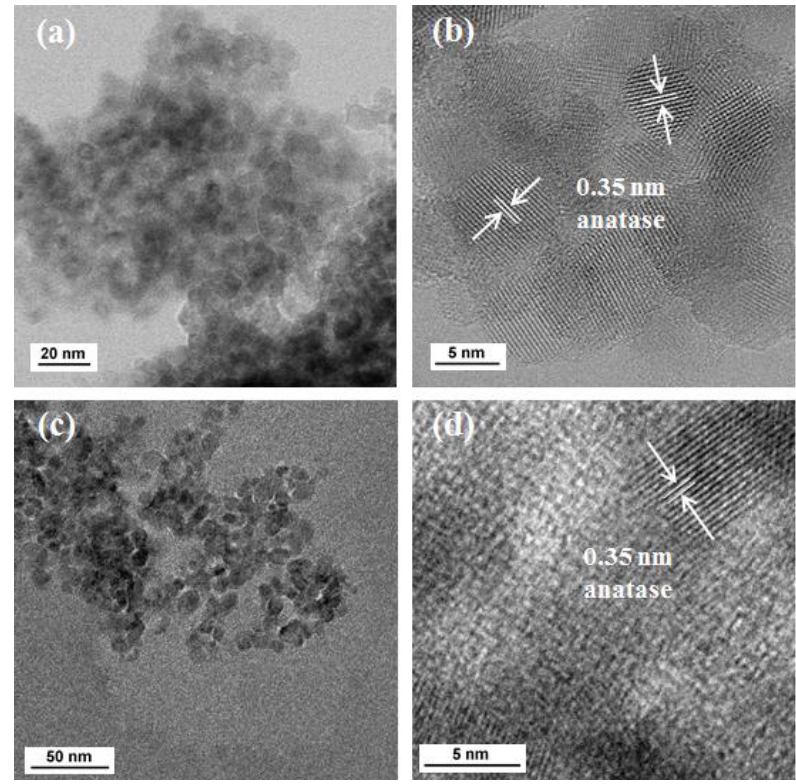
Figure 4. TEM and HRTEM micrographs of catalysts ( a , b ) Cu/TiO 2 and ( c , d ) TiO 2 .